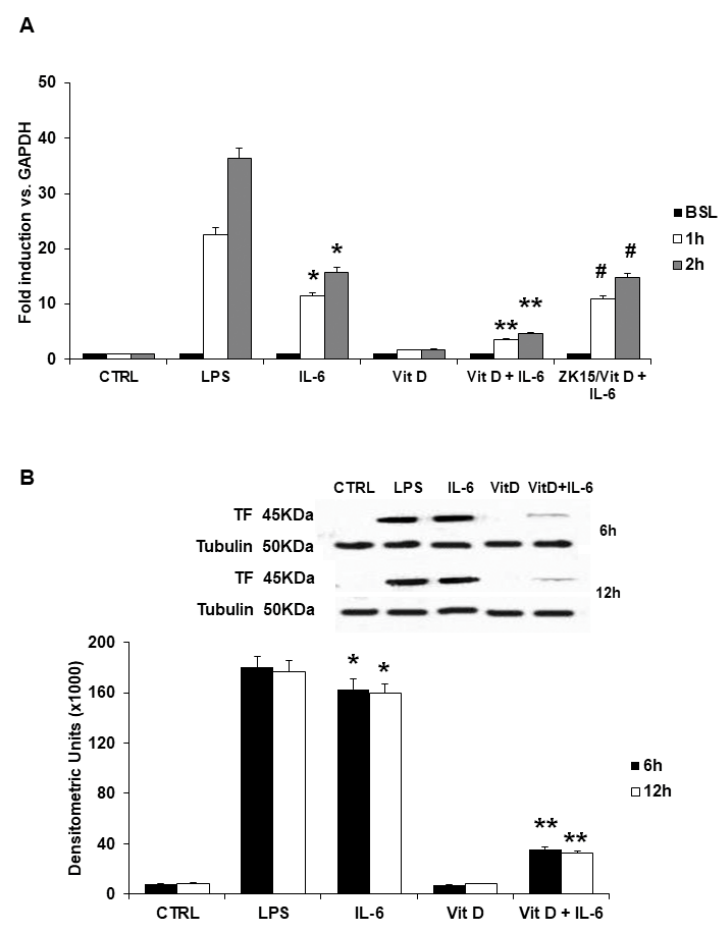
Figure 1. ( A ) Effects of VitD on IL-6-induced TF transcription in human endothelial cells assessed by Real Time quantitative PCR. TF mRNA was undetectable at baseline. Incubation with IL-6 caused significant increase in TF-mRNA levels, as compared to unstimulated cells. Preincubation with VitD inhibited the IL-6 effect on TF-mRNA. The use of ZK15, a VDR antagonist, completely abolished its effect. LPS served as positive control. Data are expressed as fold induction versus control gene represented by GAPDH. Each bar represents the mean ± SD of 3 different experiments. (* p < 0.001 vs. Control; ** p < 0.001 vs. IL-6; # p = NS vs. IL-6; one-way ANOVA with Tukey’s post hoc test). ( B ) Effects of VitD on IL-6-induced TF protein evaluated by Western blot analysis of cell lysates. IL-6 caused a significant increase in TF protein levels. These effects were prevented by treatment with VitD. Tubulin served as loading control. LPS served as positive control. Each bar represents the mean ± SD of 6 different experiments (* p < 0.001 vs. Control; ** p < 0.001 vs. IL-6; one-way ANOVA with Tukey’s post hoc test). The insert shows results of a representative experiment.